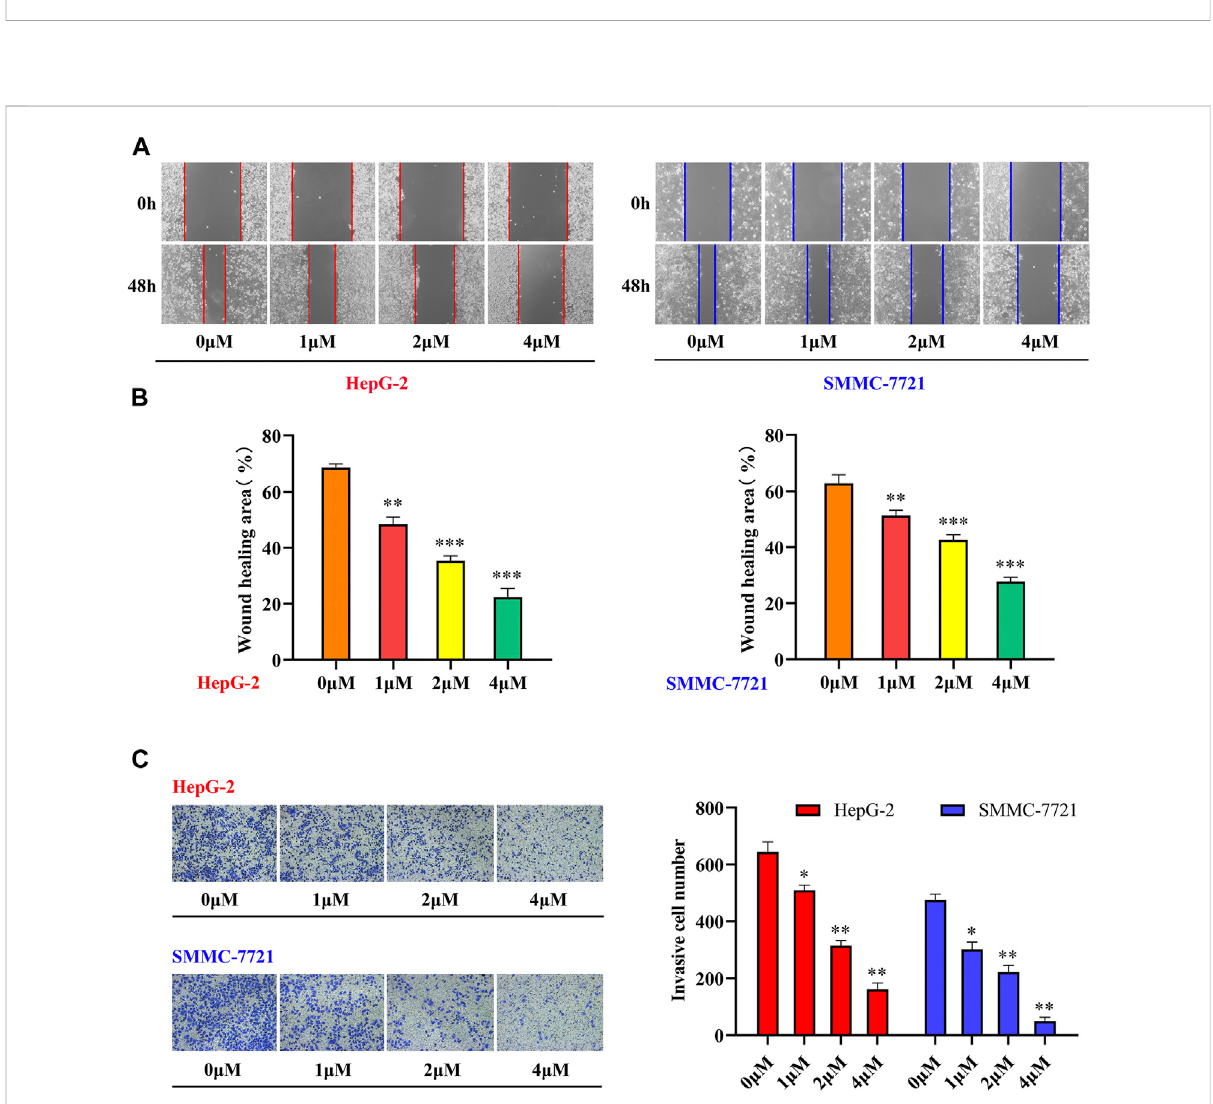
FIGURE 2 Compound 33 suppressesthemotilityofHCCcells invitro . (A,B) HepG-2andSMMC-7721cellsweretreatedwithdifferentconcentrations(0,1, 2, and 4 μ M) of 33 to analyze wound healing. (C) Invasion cell numbers were analyzed using a transwell assay in HepG-2 and SMMC-7721 cells treated with different concentrations (0, 1, 2, and 4 μ M) of compound 33 . * p < 0.05, ** p < 0.01, *** p < 0.001.